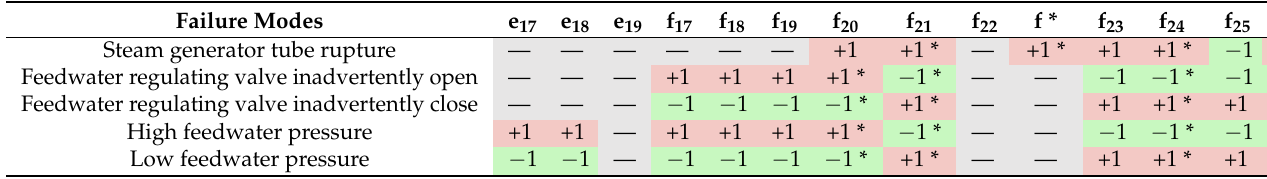
Table 7. The fault signature matrix of the steam generator.